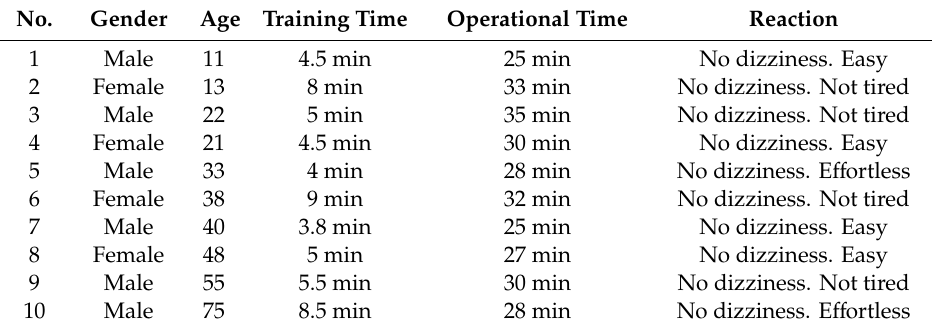
Table 4. Usage evaluation for di ff erent